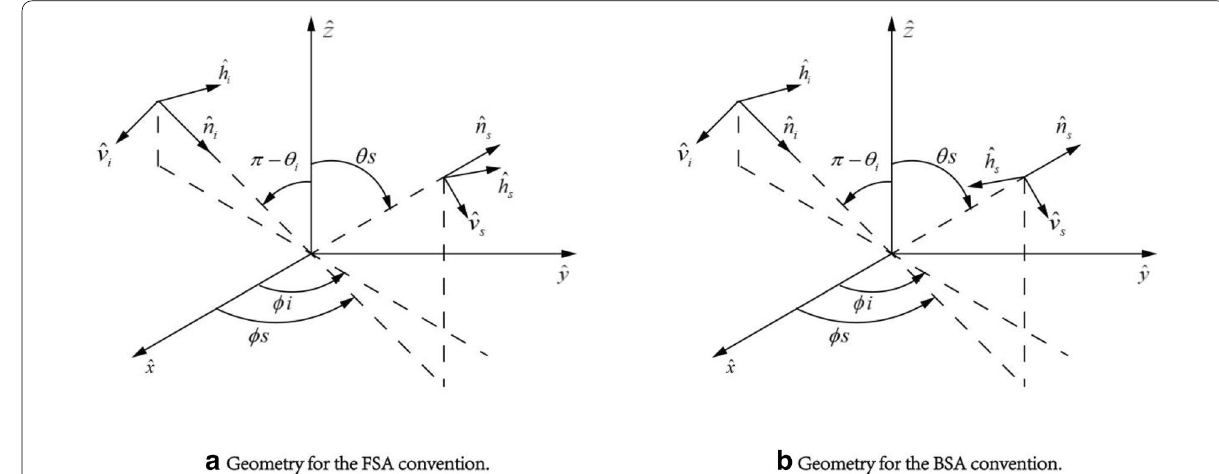
Fig. 1 Geometry for the polarization coordinate systems